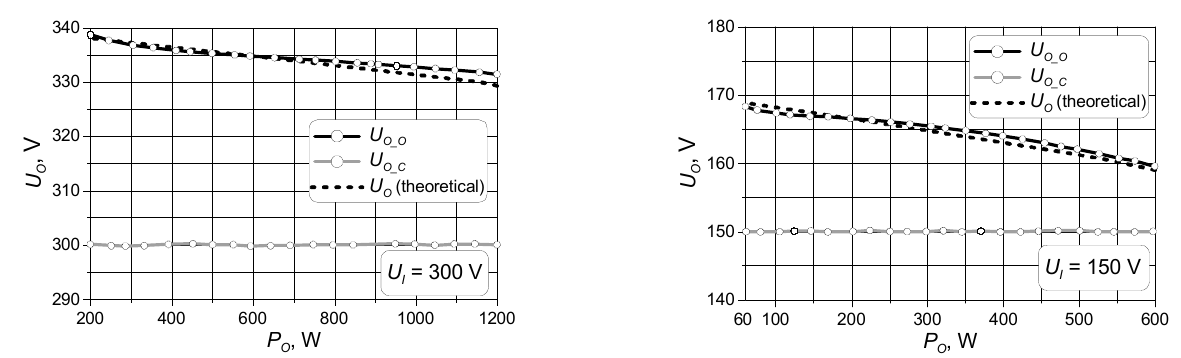
Figure 9. Output voltage as a function of output power ( U I = 300 and 150 V).